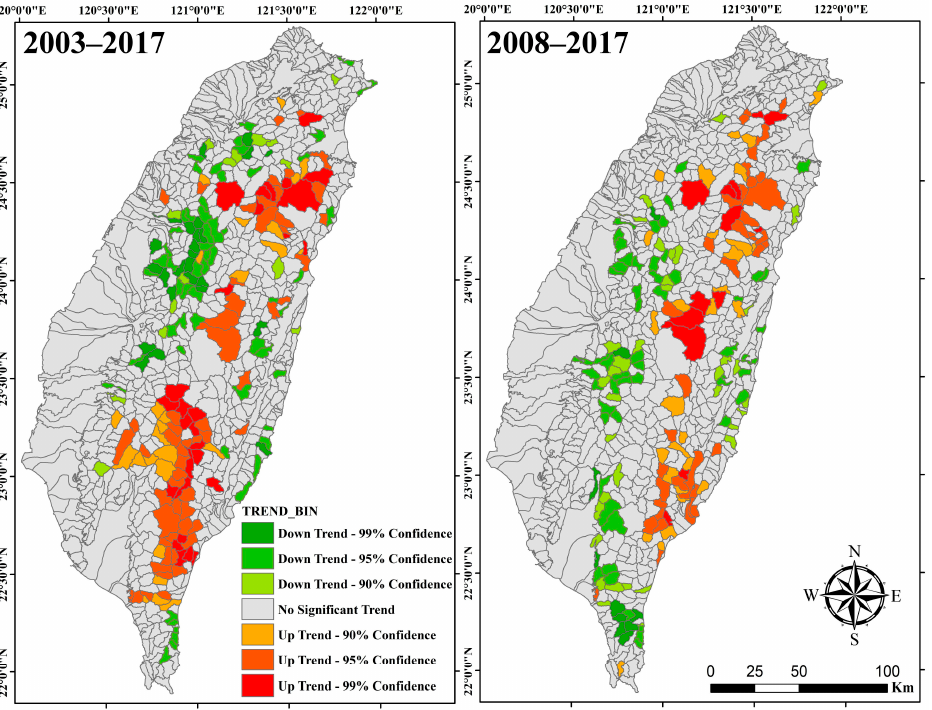
Figure 6. The Mann–Kendall trend test for the landslide cube model in 2003–2017 ( left ) and 2008–2017 ( right ).